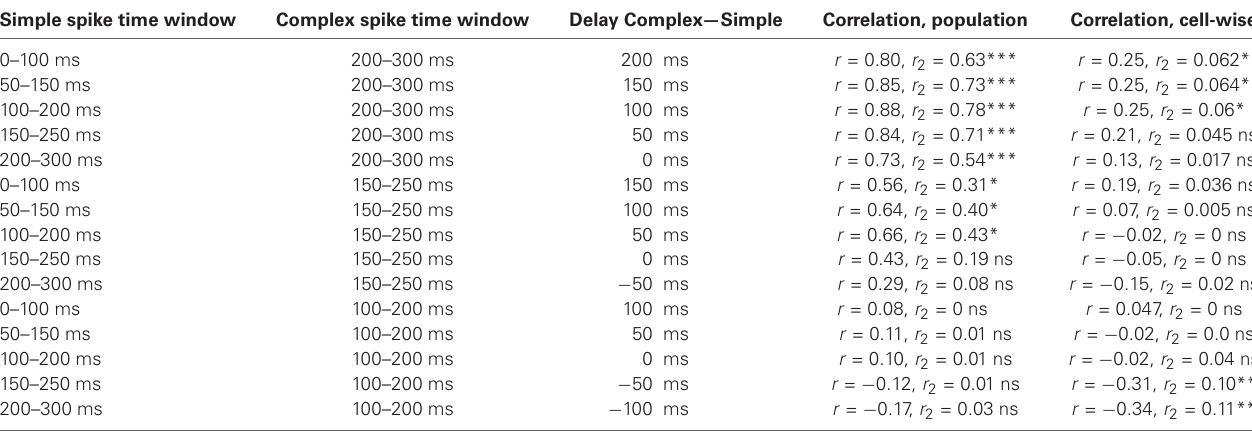
Table 1 | Correlation between pooled and un-pooled simple and complex spike activity in different 100 ms time windows during the CS, in the acquisition phase (* p < 0.05, ** p < 0.01, *** p < 0.001) . Simple spike time